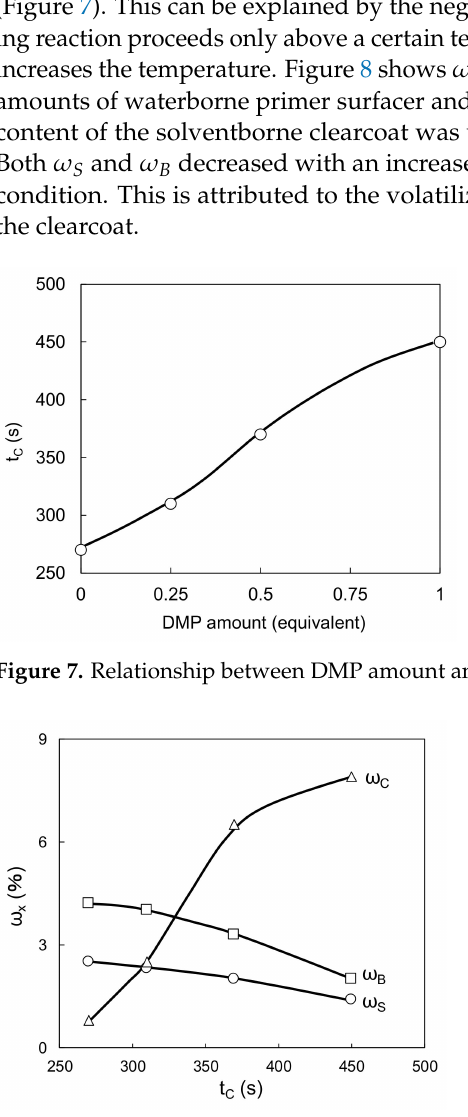
Figure 8. Relationship between t C and ω ( ω S ; primer surfacer, ω B ; basecoat; ω C ;